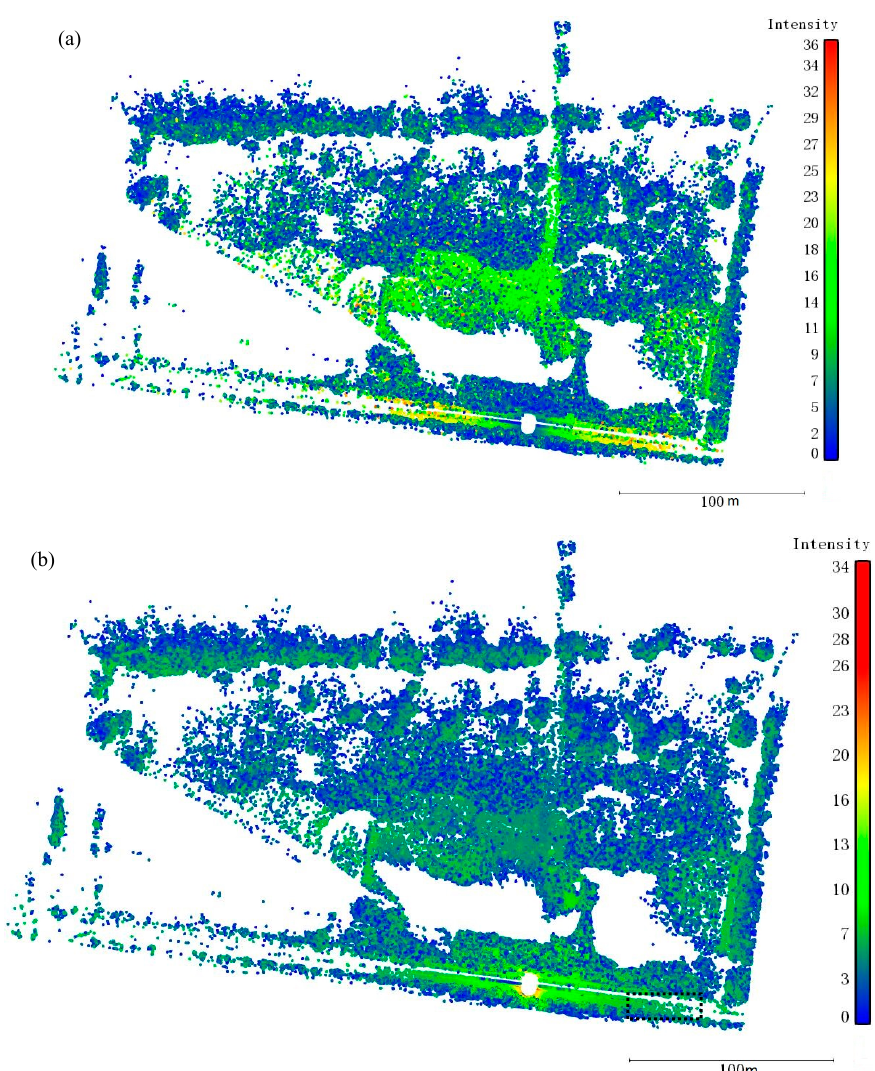
Figure 8. Point cloud colored by intensity. ( a ) Incidence angle-corrected intensity by using the first equation of Equation (5). ( b ) Distance-corrected intensity by using the second equation of Equation (5). The total number of points is 931,381. The white parts among the figures have no measured points considering water accumulation or occlusion.